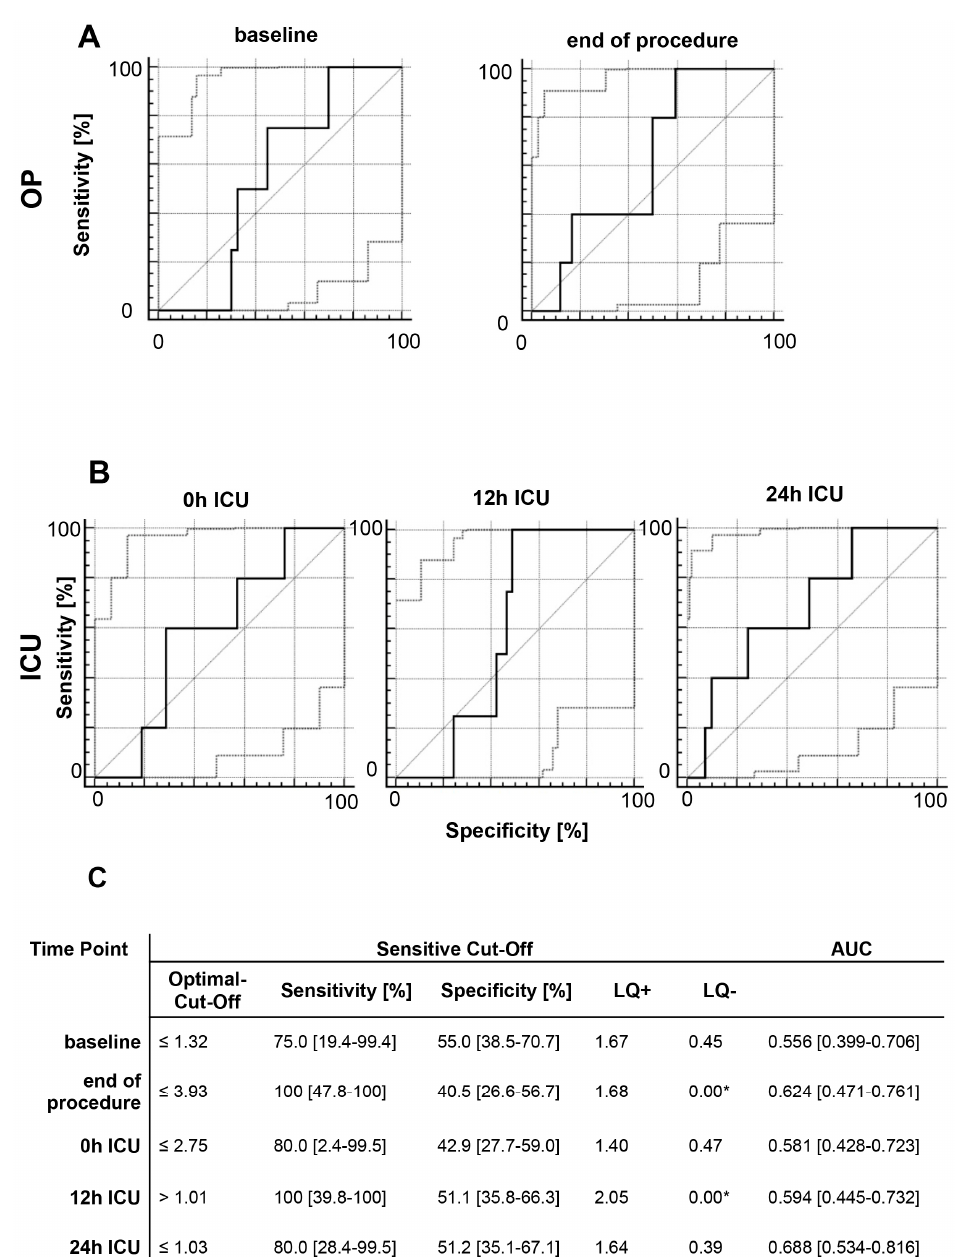
Figure 2. ROC analysis of perioperative MIF levels and patient survival. ROC analysis was performed to evaluate the diagnostic capacities of ( A ) perioperative MIF levels and ( B ) MIF levels during ICU admission with regard to survival. If an elevated MIF value indicates that the patient is likely to die after surgery, the ROC curve should be farther from the bisecting line (Sensitivity = 1 − Specificity). ( C ) Sensitivity (Se), specificity (Sp), likelihood ratios (LR +/ − ), and area under the curve (AUC) are reported for either the Youden optimal cut-off (maximize Se + Sp − 1) or for a sensitivity cut-off of at least 75%. * Good-to-moderate diagnostic quality: LQ+ of >3 and LQ − of <0.3. * Excellent diagnostic quality: LQ+ of >10 and LQ − of >0.1.